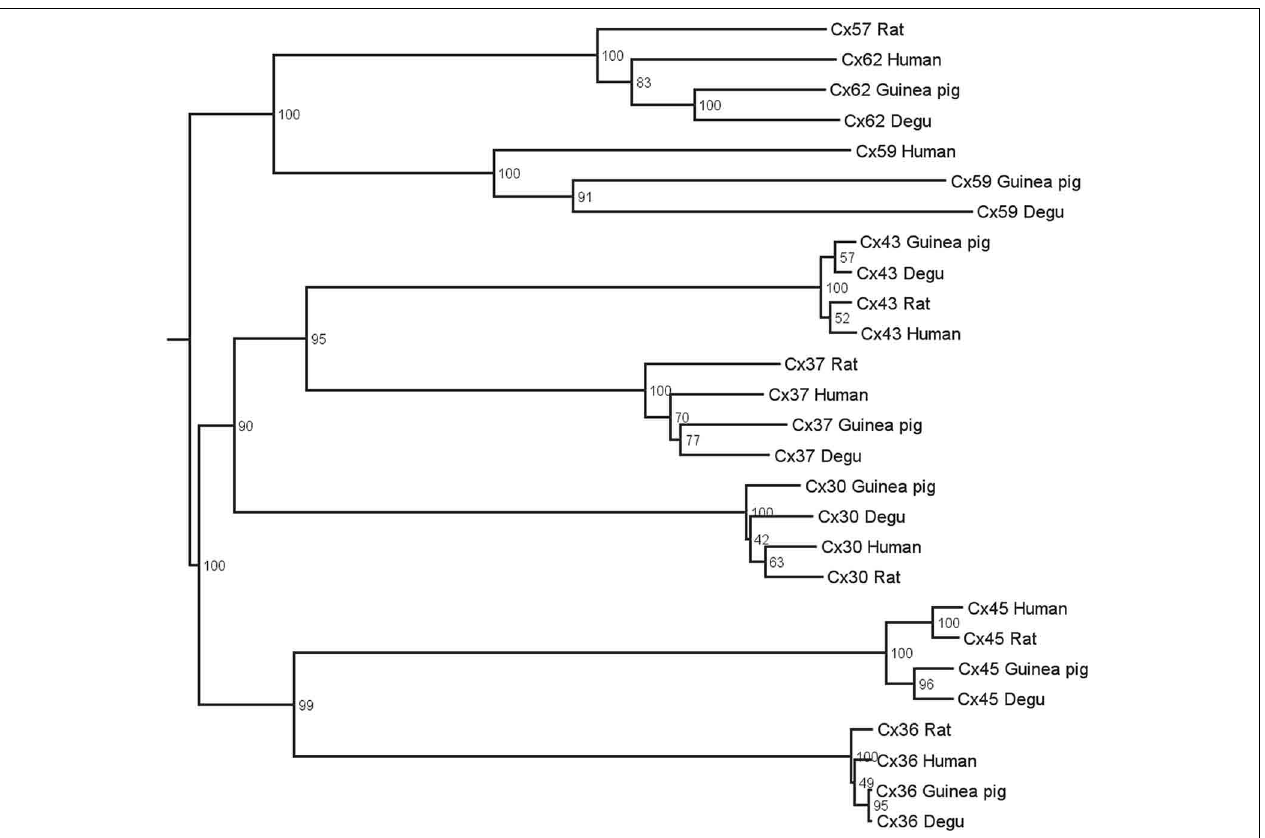
FIGURE 1 | Phylogenetic tree of gap junctions present in the retina of different mammals. Multiple alignments with subsequent neighbor-joining and bootstrap analysis were performed on protein